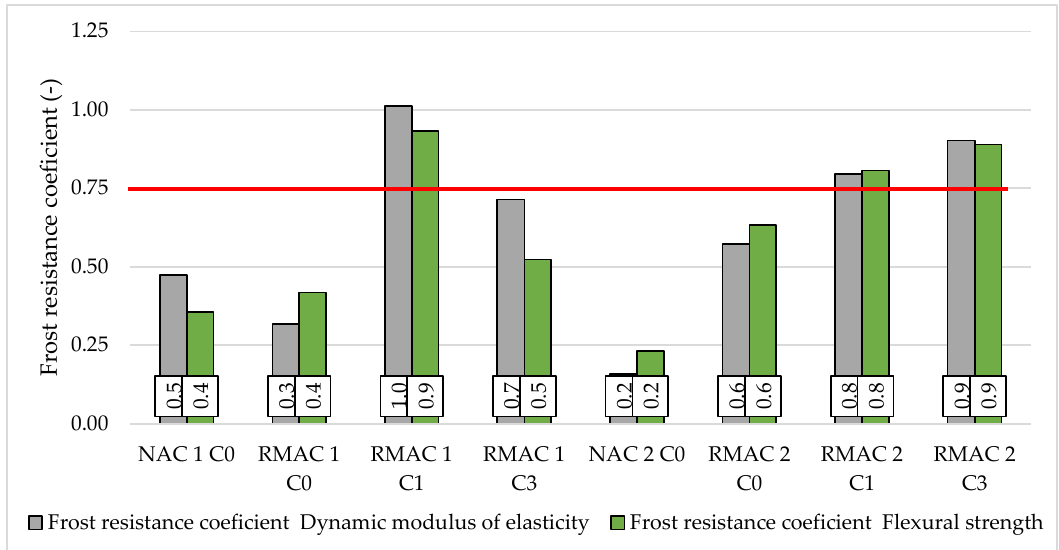
Figure 7. The comparison of the frost resistance coe ffi cients evaluated from dynamic modulus of elasticity and flexural strength.